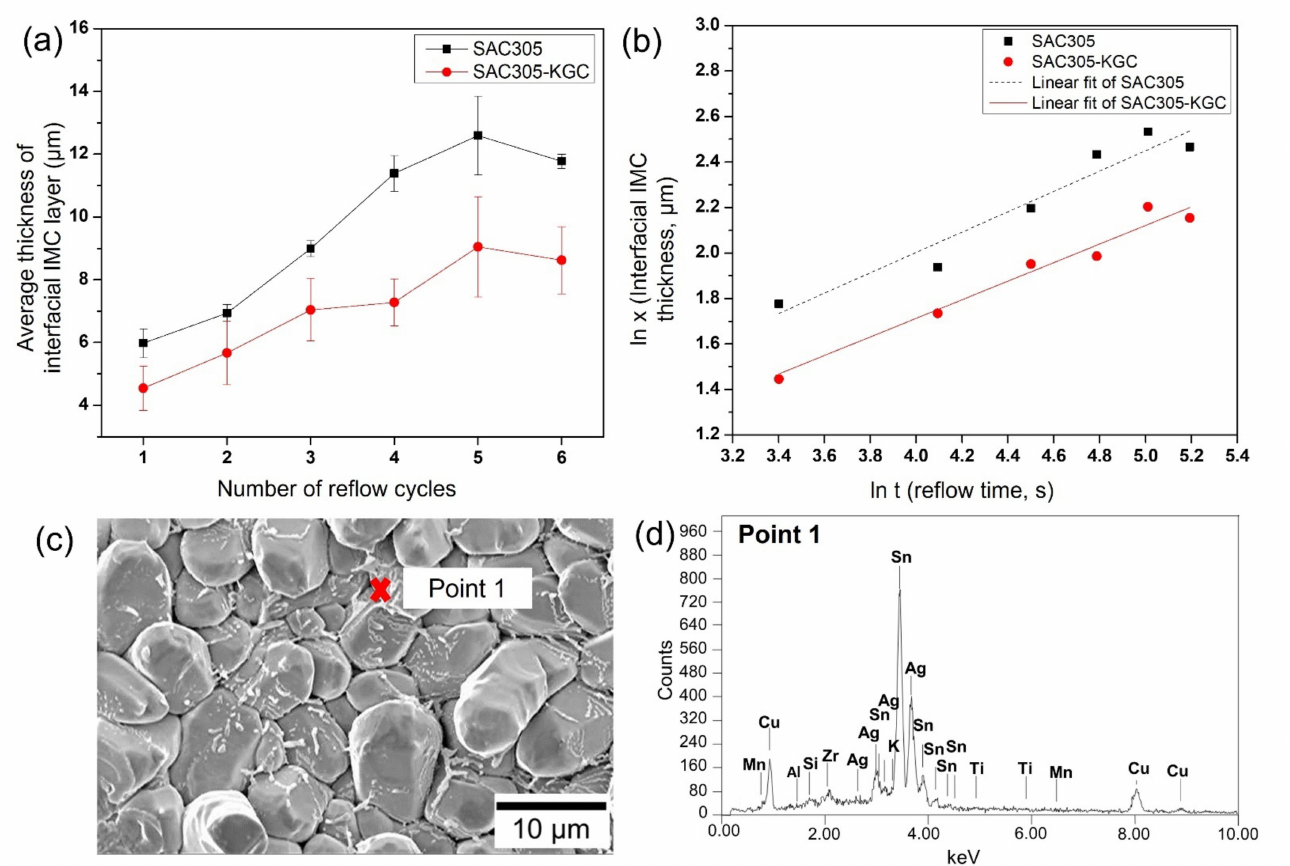
Figure 5. ( a ) Average thickness of interfacial intermetallic compound (IMC) layer at different reflow cycles, ( b ) ln plot growth of interfacial IMC layer respected to different reflow cycles, ( c ) Top view of interfacial IMC layer in SAC305-KGC after 6th cycle reflow, and ( d ) EDX point analysis at Point